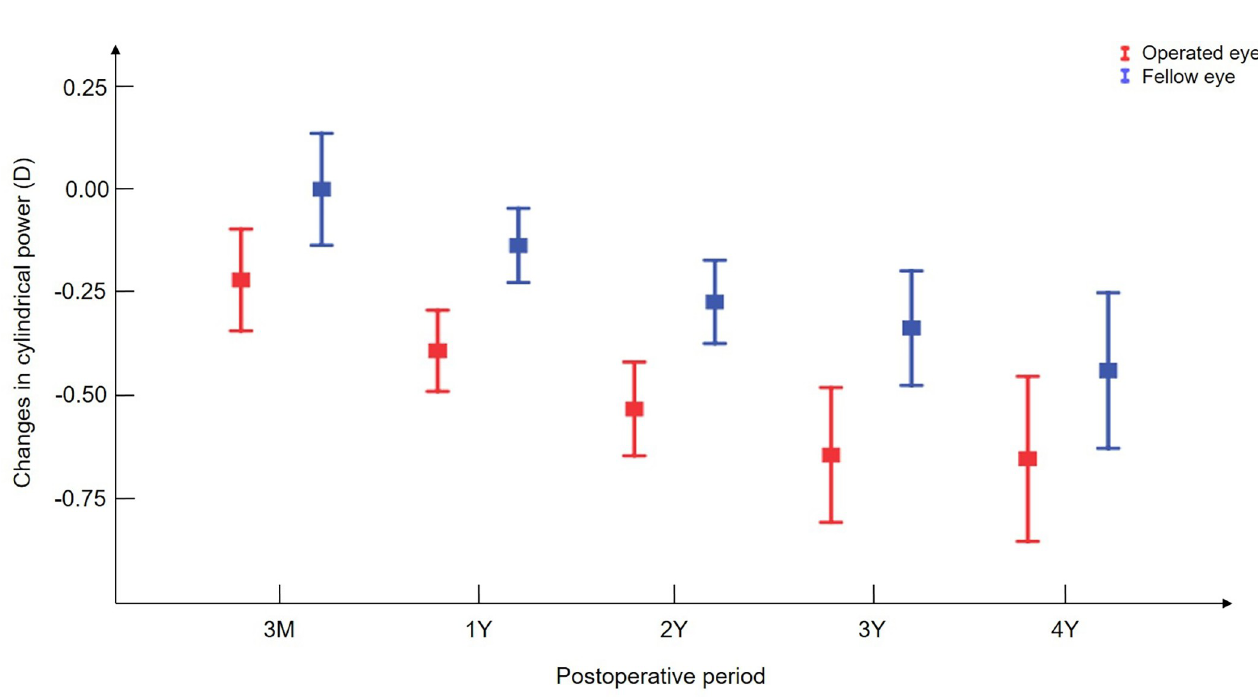
Fig 2. Changes in the cylindrical power of both eyes over time. The course of the operated eyes is presented as blue lines and that of the fellow eyes as red lines. The error bar indicates the standard error of the mean.